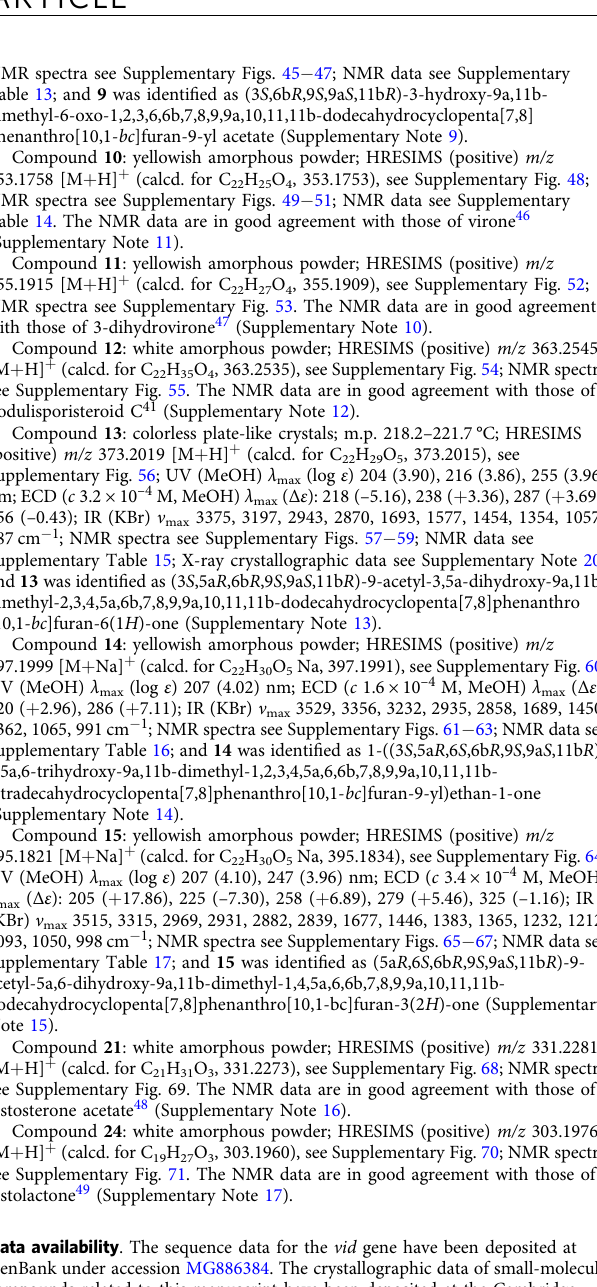
Supplementary Table 17; and 15 was identi fi ed as (5a R ,6 S ,6b R ,9 S ,9a S ,11b R )-9- acetyl-5a,6-dihydroxy-9a,11b-dimethyl-1,4,5a,6,6b,7,8,9,9a,10,11,11b- dodecahydrocyclopenta[7,8]phenanthro[10,1-bc]furan-3(2 H )-one (Supplementary Note 15). Compound 21 : white amorphous powder; HRESIMS (positive) m/z 331.2281 [M + H] + (calcd. for C 21 H 31 O 3 , 331.2273), see Supplementary Fig. 68; NMR spectra see Supplementary Fig. 69. The NMR data are in good agreement with those of testosterone acetate 48 (Supplementary Note 16). Compound 24 : white amorphous powder; HRESIMS (positive) m/z 303.1976 [M + H] + (calcd. for C 19 H 27 O 3 , 303.1960), see Supplementary Fig. 70; NMR spectra see Supplementary Fig. 71. The NMR data are in good agreement with those of testolactone 49 (Supplementary Note 17).